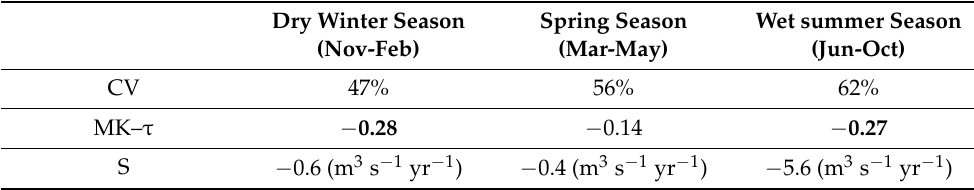
Table 2. The change and trend on seasonal Lhasa River discharge for the time period of 2000–2016. CV stands for coefficient of variation, MK– τ represents Mann–Kendall’s trend at p = 0.05 (bold values are significant at p ), and S represents the Sen’s slope estimator for change in LR discharge (m 3 s − 1 month − 1 ). The negative sign indicates a decrease.